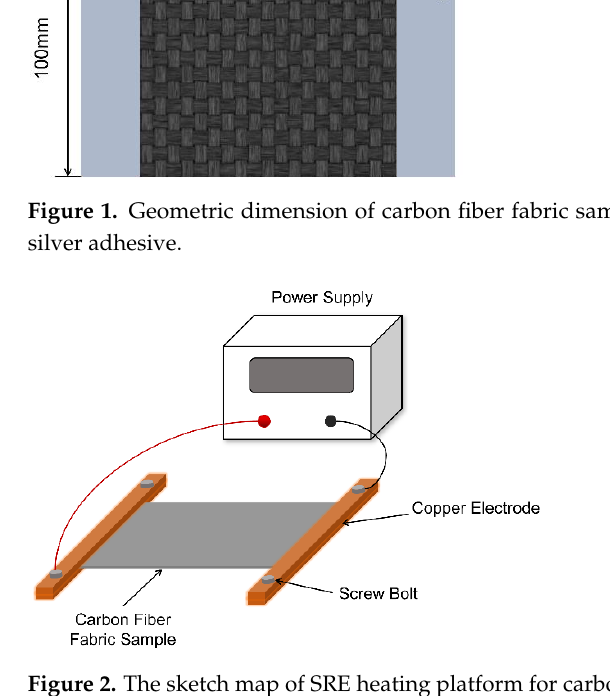
Figure 2. The sketch map of SRE heating platform for carbon fiber fabric.